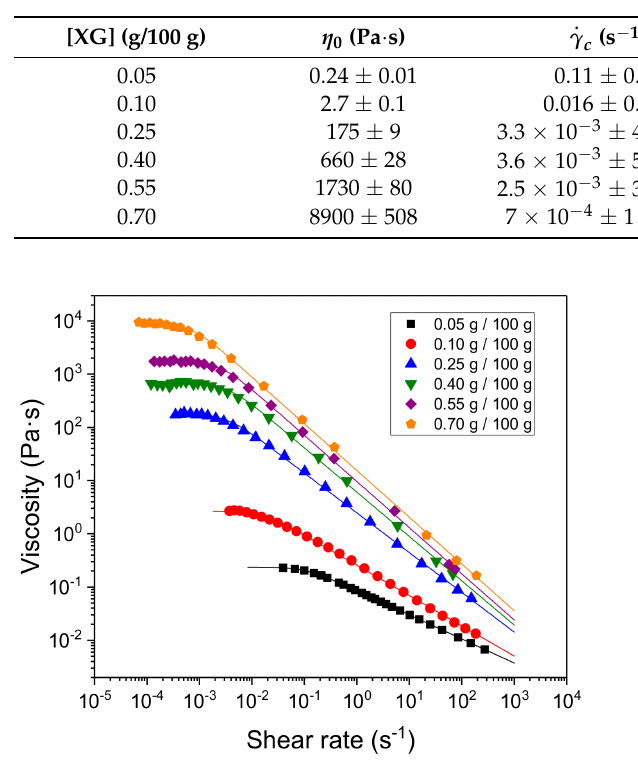
Table 2. Fitting parameter values for the Carreau model. The values were obtained by a non-linear regression analysis.